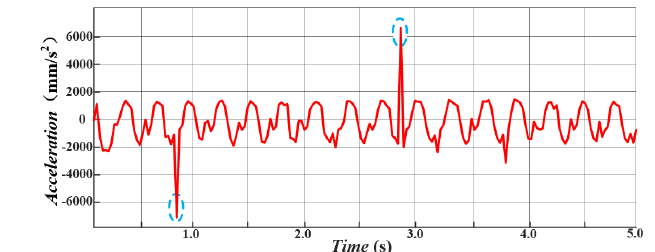
Figure 9. Displacement of the foot end in the x direction.